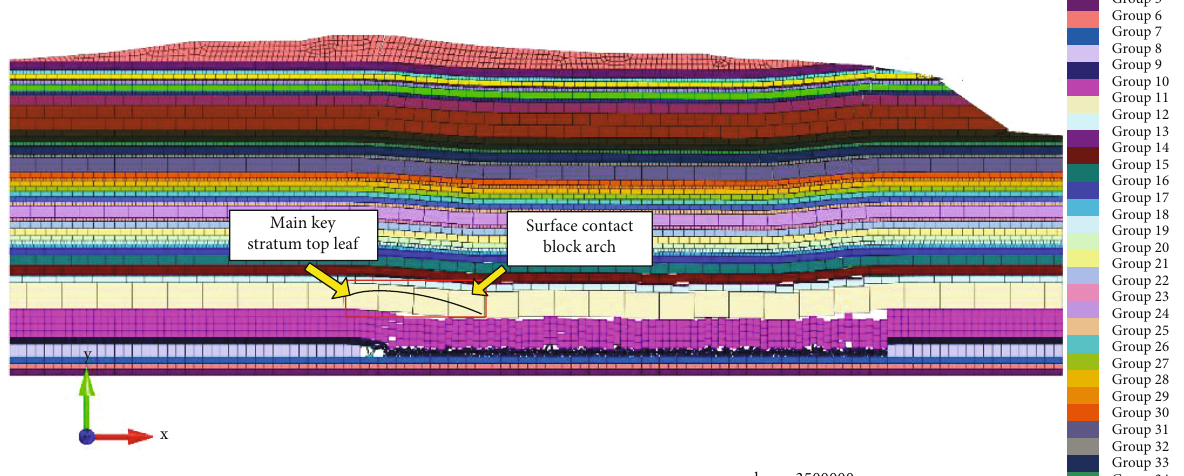
Figure 5: Simulation results during the advance of the working